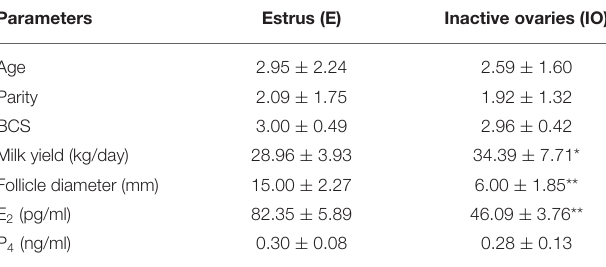
Frontiers in Veterinary Science |